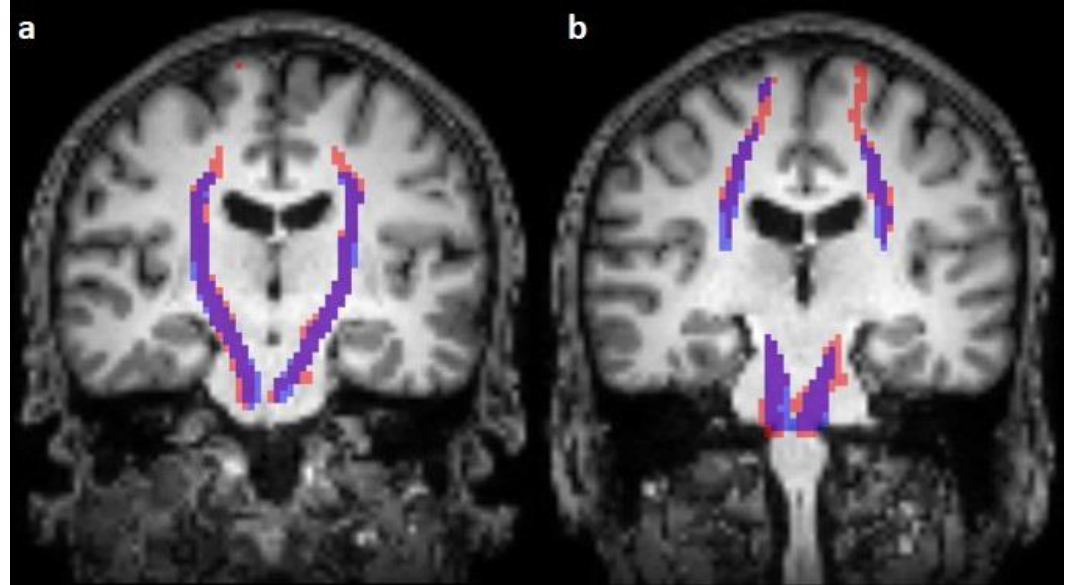
Figure 2. Comparison of the predicted (blue) and reconstructed (red) course of the corticospinal tract on coronal T1-weighted images ( a , b ).